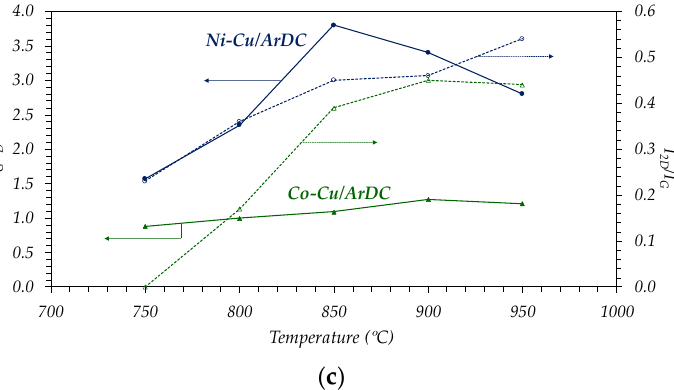
Figure 4. Influence of temperature on the Raman results of the used catalysts: ( a ) Ni–Cu/ArDC; ( b ) Co–Cu/ArDC, ( c ) I G /I D (solid symbols) and I 2D /I G (open symbols) ratios.